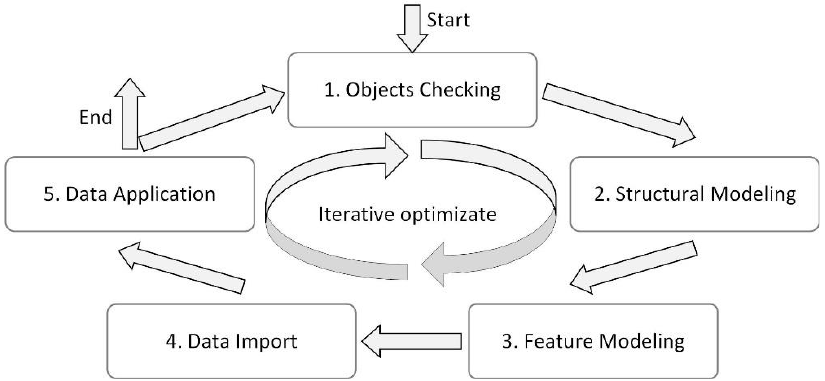
Figure 1. Framework of the proposed digital twin modeling method for complex mechanical products.